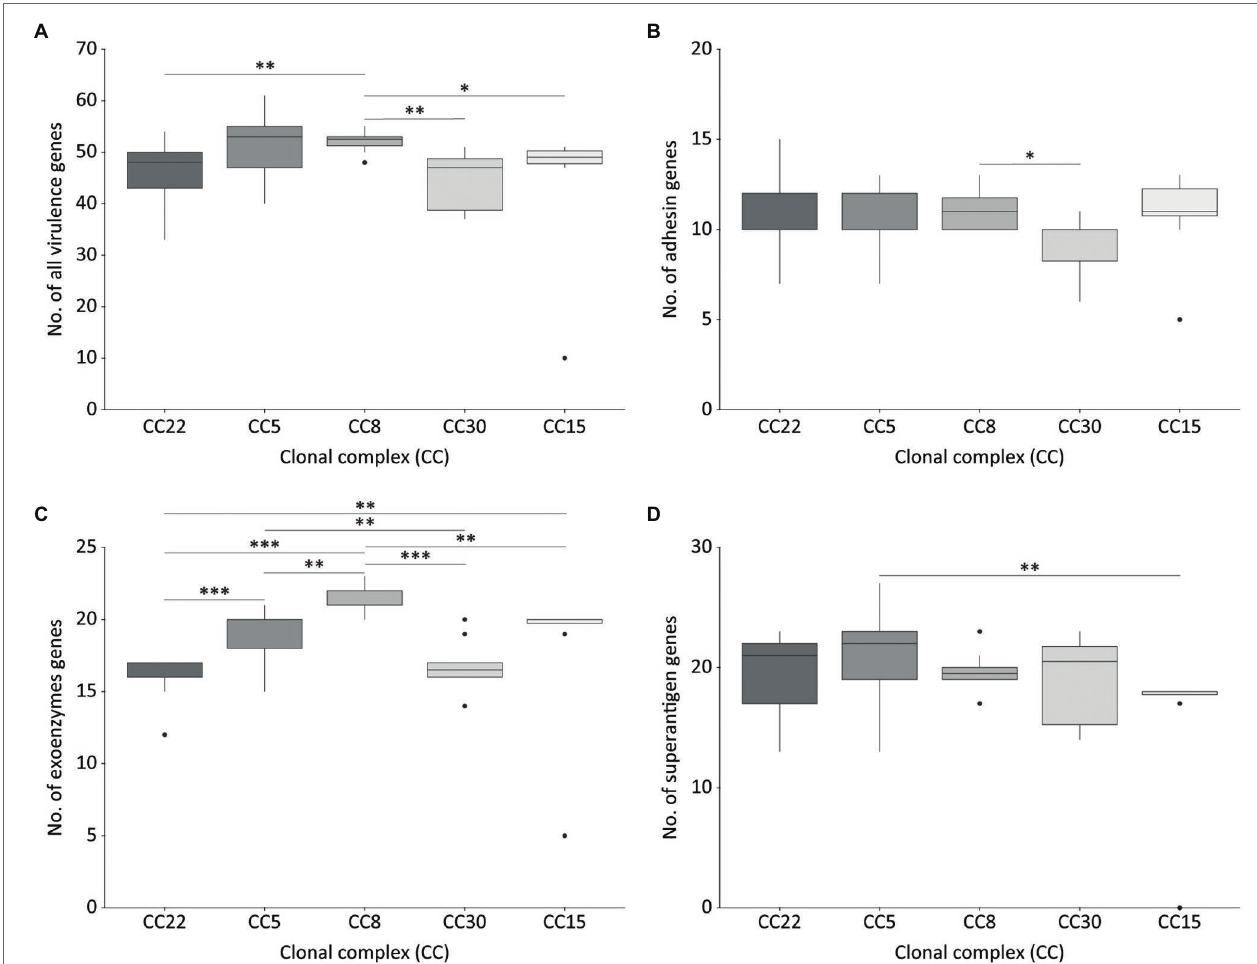
FIGURE 3 | Virulence-related genes detected in isolates belonging to the most frequent Staphylococcus aureus clonal complexes (CC) causing OM. All virulence genes (A) , adhesin genes (B) , exoenzymes genes (C) , and superantigen genes (D) . CC22, n = 21; CC5, n = 13; CC8, n = 10; CC30, n = 10; CC15, n = 8. The significance of the differences in the number of virulence factors between CCs was assessed using the Mann–Whitney-Wilcoxon’s test (non-normally distributed data) for all pairwise comparisons with the exception of CC15 vs. CC30, for which Student’s t -test was employed (normally distributed data). Boxes denote the second and third quartiles, vertical lines (whisker) the smallest and largest values of the first and fourth quartiles, with outliers marked by dots. * p < 0.05, ** p < 0.01, and *** p <